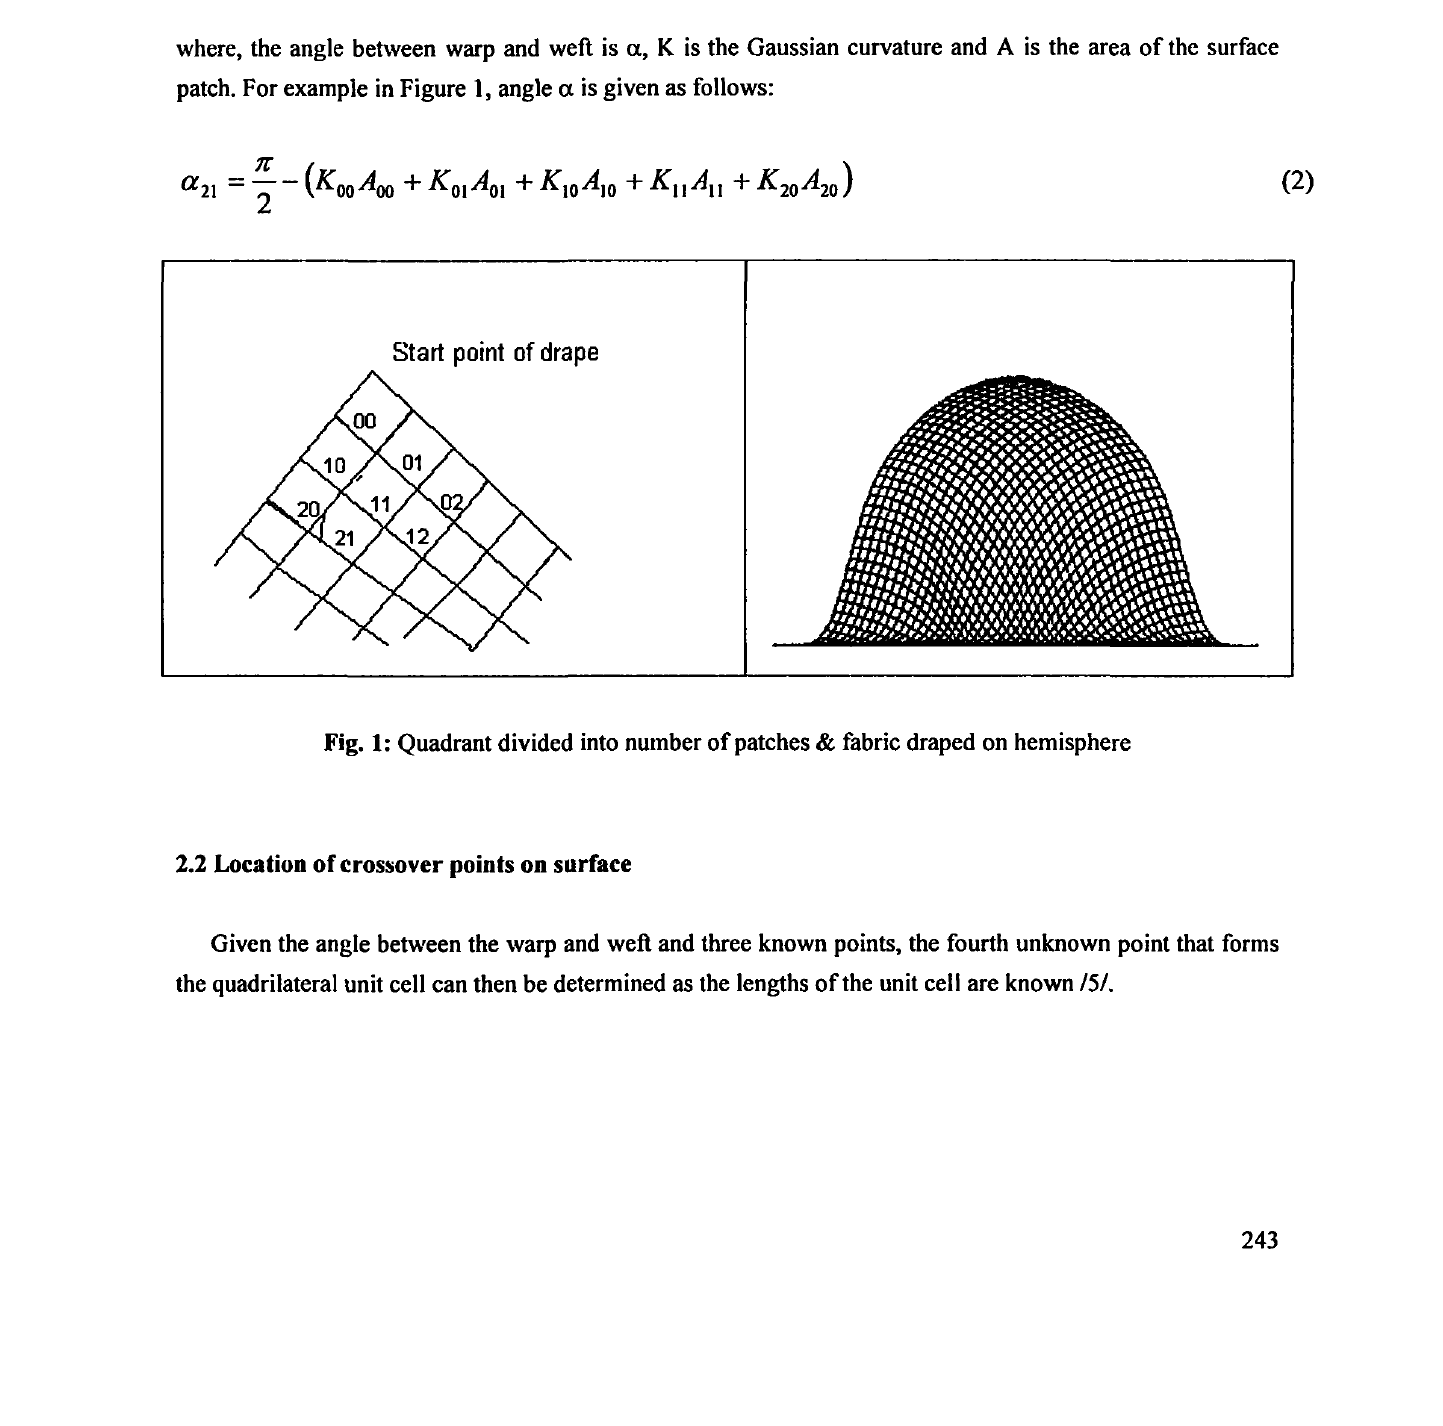
Fig. 1: Quadrant divided into number of patches & fabric draped on